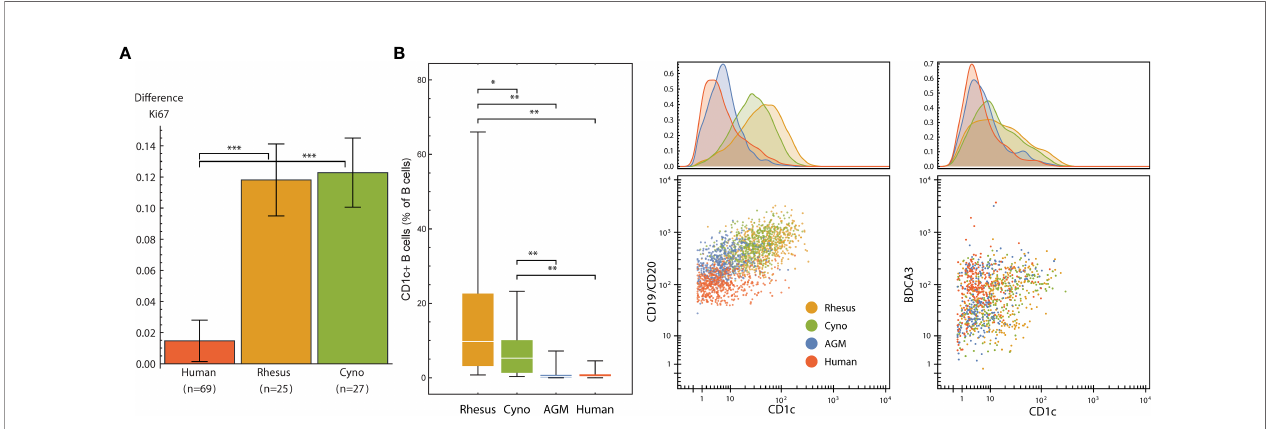
FIGURE 7 | (A) Neutrophil Ki67 induction (mean and standard error of differences of ArcSinh-transformed values) by species after exposure to 22M CFU of gamma- irradiated Bacillus anthracis for 15 minutes. (B) CD1c+ B cells are more abundant in non-human primates than in humans, and CD1c is furthermore expressed at higher levels in NHP B cells, especially in macaques. Left: Abundance of CD1c+ B cells (expressed as % of total B cells) in each species. Middle and right: One representative individual from each species. Dot plots show 500 randomly selected B cells (middle) or 250 randomly selected CD11b-/CD16- DCs (right). Statistics (A, B) : Groups were compared using a one-tailed Mann-Whitney U test with asterisks indicating signi fi cant differences (*p < 5x10 -2 , **p < 1x10 -2 , ***p < 1x10 -3